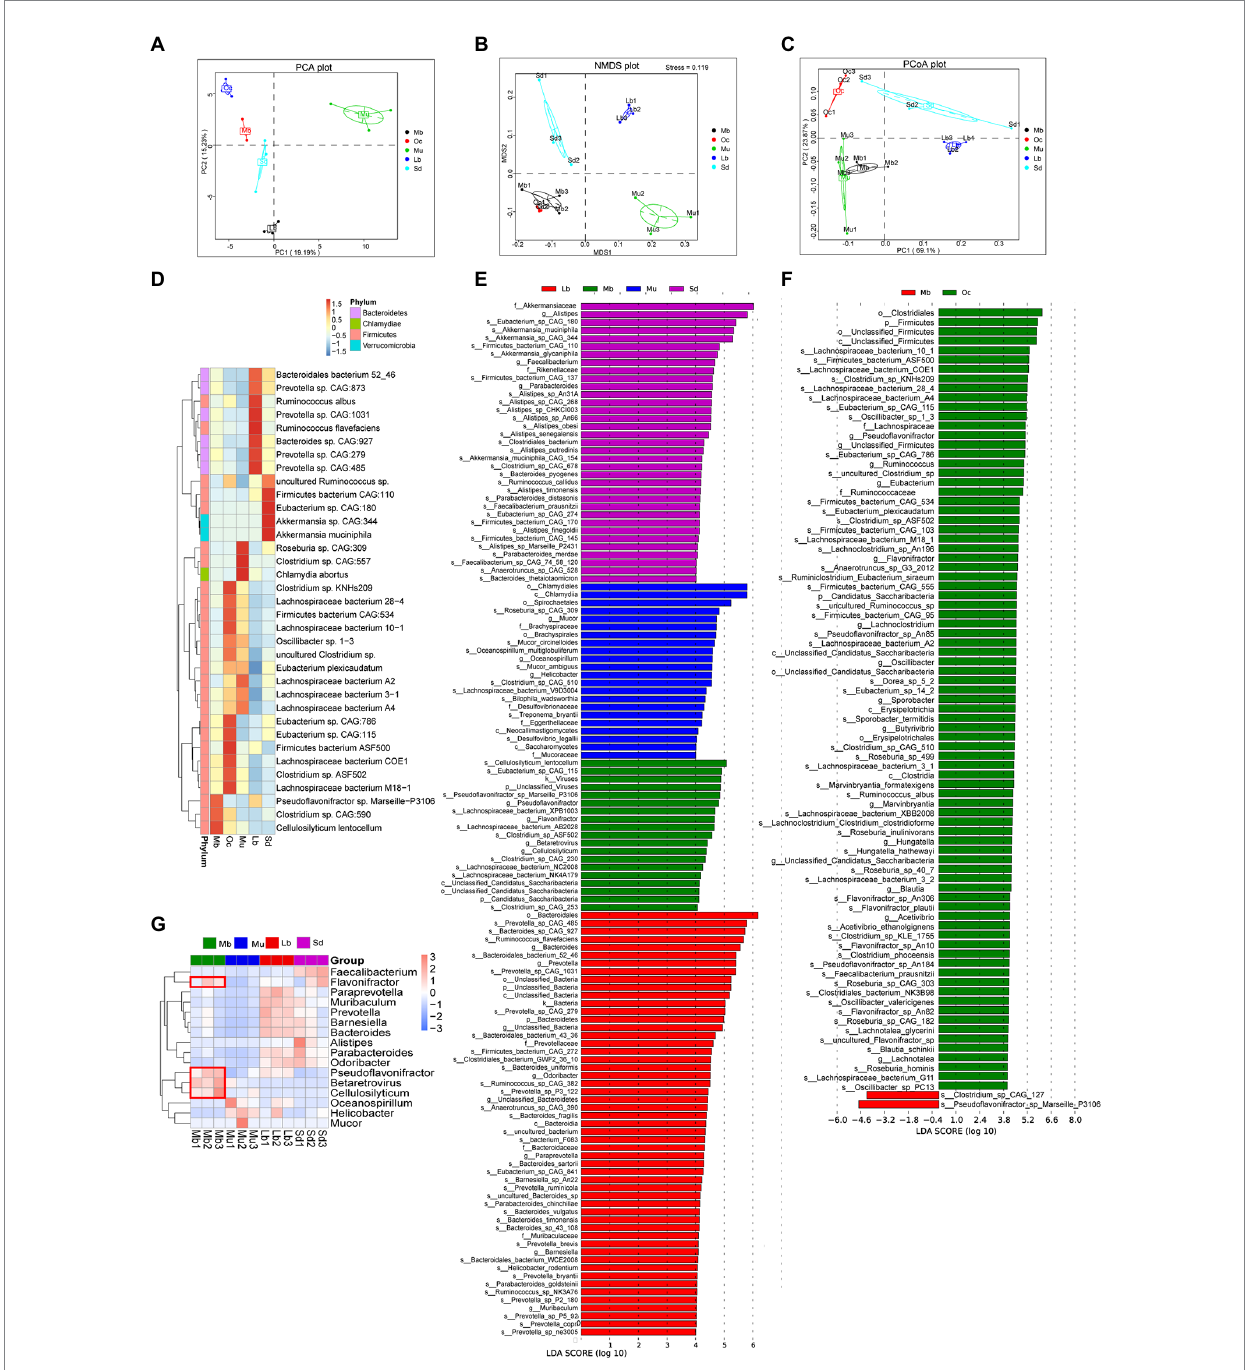
FIGURE 3 Analysis of gut microbiota with significant differences. (A) PCA analysis among the Mb, Oc, Mu, Lb, and Sd groups under phyla level. The horizontal coordinates indicate one principal component, vertical coordinates indicate the second principal component, percentages indicate the contribution of the principal component to sample variation, each point in the figure represents a sample, and the samples are represented by the same color. (B) NMDS analysis among the Mb, Oc, Mu, Lb, and Sd groups under phyla level (Stress = 0.119). Each point in the graph represents a sample, and the distance between points represents the degree of difference. When the Stress is less than 0.2, it indicates that the NMDS analysis has certain reliability. (C) PCoA analysis among the Mb, Oc, Mu, Lb, and Sd groups under phyla level The horizontal coordinate indicates one principal component, the vertical coordinate indicates another principal component, and the percentage indicates the contribution of the principal component to the variance of the samples. (D) Relative abundances of bacterial species among the Mb, Oc, Mu, Lb, and Sd groups. (E) The featured microbial taxa of each animal species according to the results of LEfSe differential analysis. The bar chart of the distribution of LDA score shows microbial taxa with an LDA Score greater than a set value (LDA score > 4.0), i.e., Biomarkers that are statistically different between the Mb, Mu, Lb, and Sd groups, and the length of the bar chart represents the size of the effect of the differential species. (F) The featured microbial taxa of each animal species according to the results of LEfSe differential analysis. The differential analysis was conducted between the Mb and Oc groups (LDA score > 4.0). (G) Relative abundances of bacterial taxa (Biomarker with statistical differences) varied across the Mb, Mu, Lb, and Sd samples according to the results of LEfSe (LDA score >